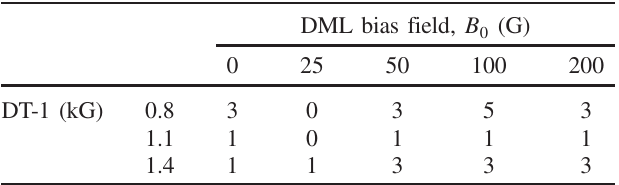
TABLE IV. Number of beam shots vs magnetic